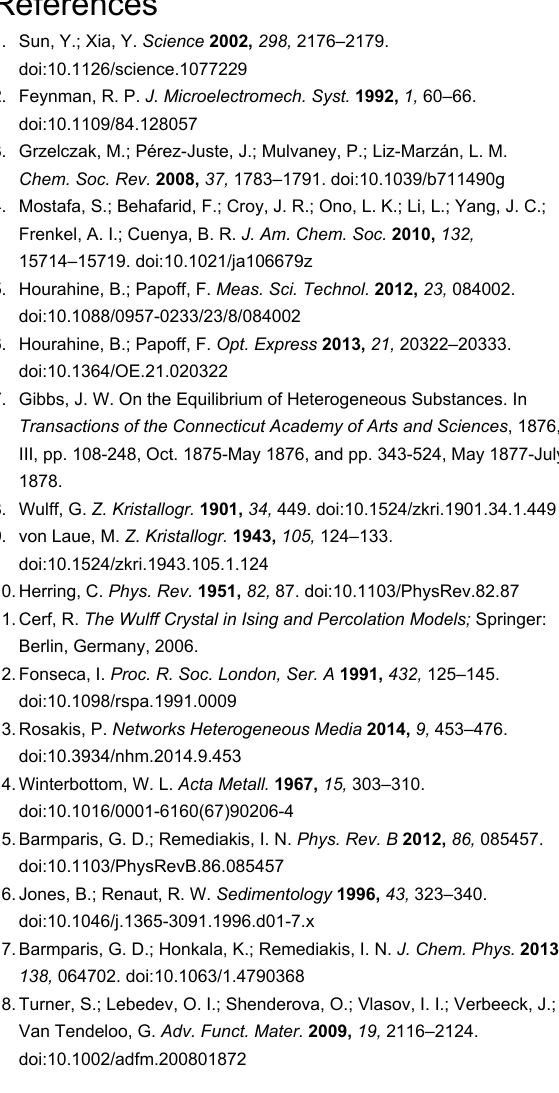
Figure 4: Wulff construction for the nanoparticles of LiBH 4 . The blue spheres are for lithium, red for boron and white are hydrogen atoms.